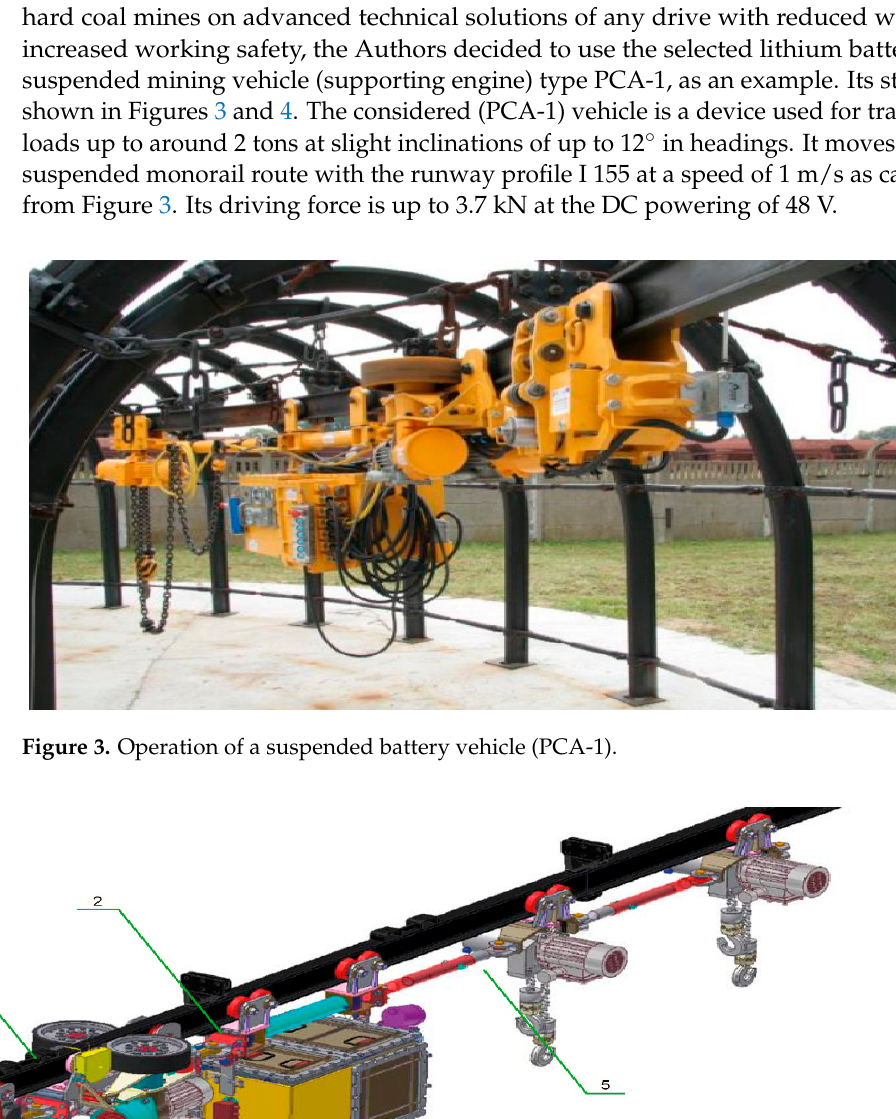
Figure 4. General view of a suspended battery vehicle (PCA-1) (1—driving trolley; 2—apparatus trolley; 3—power supply module with electrical equipment; 4—brake trolley; 5—transport set).